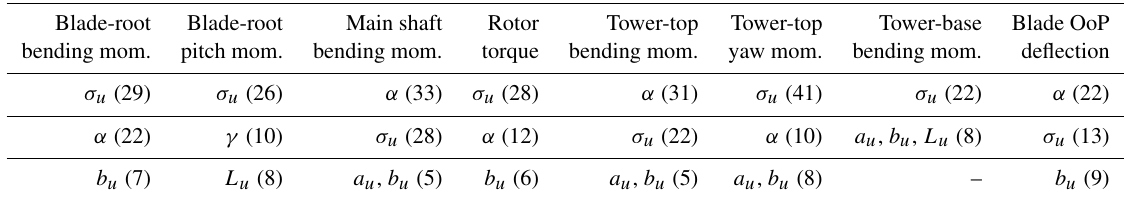
Table 4. Primary input parameters contributing to ultimate load sensitivity of each QoI. Values indicate the number of times the variable contributes to the sensitivity count.